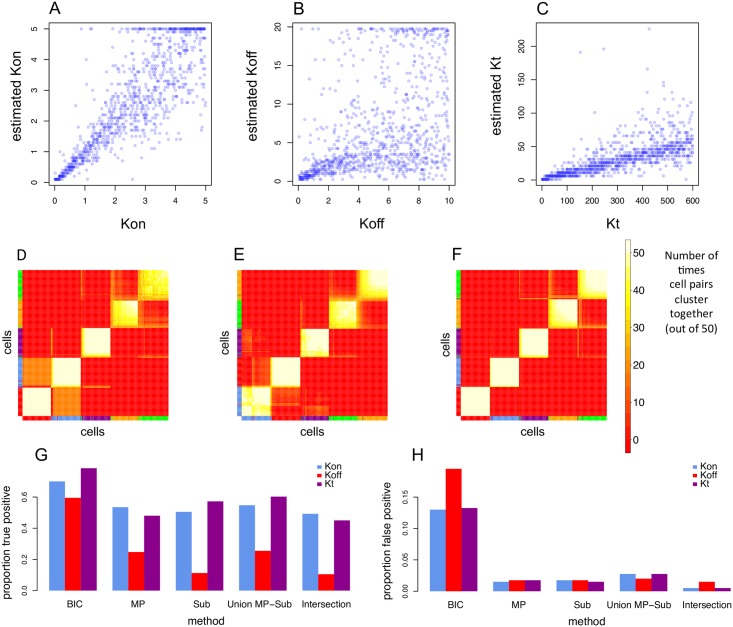
In silico validation of single cell analysis pipeline.In order to estimate the accuracy of the new tools developed in this paper, each tool was evaluated against simulated datasets. (A-C) The kinetic parameter estimation method was tested against simulated data in which 90% of the data was randomly discarded, to simulate the loss of biological material through inefficient cDNA preparation. The known kinetic parameters and the estimated kinetic parameters were compared for Kon (A), Koff (B) and Kt (C). (D-F) Next, SABEC was tested against simulated datasets that had the same kinetic parameters as those estimated for the cell populations in the Moignard single cell dataset (124 simulated cells for each of the 5 cell populations)—SABEC was tested on 100 of such simulated datasets and the robustness of the clustering was measured by calculating the proportion of ambiguously clustered cells (PAC). This figure depicts a hierarchical clustering of the consensus matrices that come from (D) the dataset whose clustering had the worst PAC score, (E) a randomly selected dataset, and (F) the dataset whose clustering had the best PAC score. The coloured bars along the side and bottom represent the true class labels of each cell. (G-H) Next, the true positive and false positive rates were calculated for each proposed component of EPiK, the union of the MP and subset method, and the intersection of all three methods. For the MP and Subset methods, thresholds were set so the false positive rate would be approximately 2%– receiver operating characteristic (ROC) curves for these are found in S13 and S14.